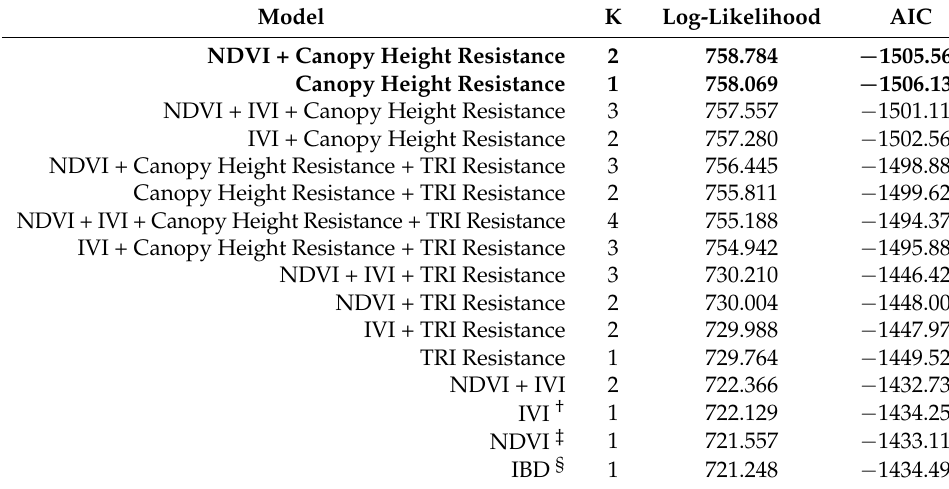
Table 7. Results for composite, within-site, and between-site gravity model predictions. Rows shown in bold indicate the best supported model based on log-likelihood criteria and corroborated using